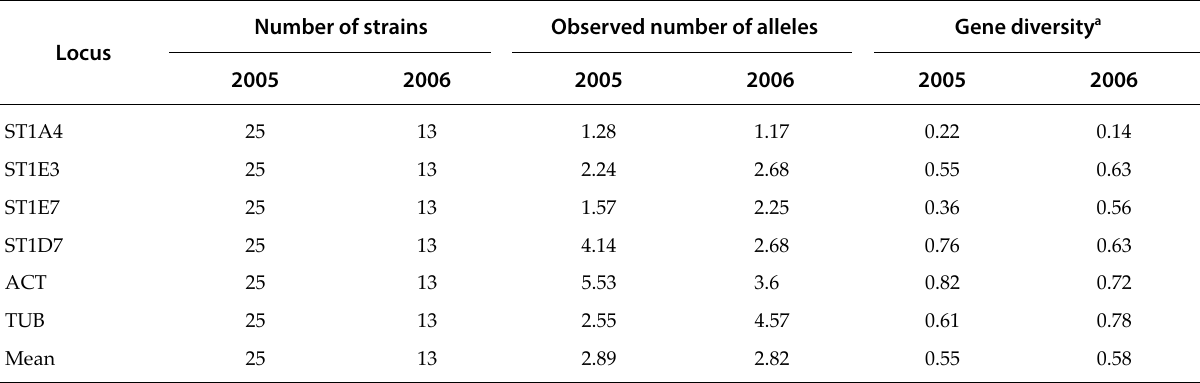
Table 1. Description of two French populations of Mycosphaerella graminicola from county 56 (Morbihan) for the six molecu- lar markers collected in the years 2005 and 2006 and before clone correction. Locus